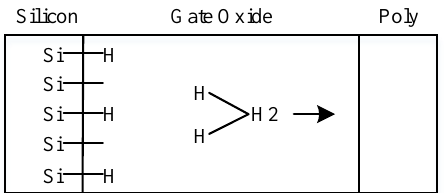
Figure 1. Schematic illustration of the R-D model to interpret interface trap generation.